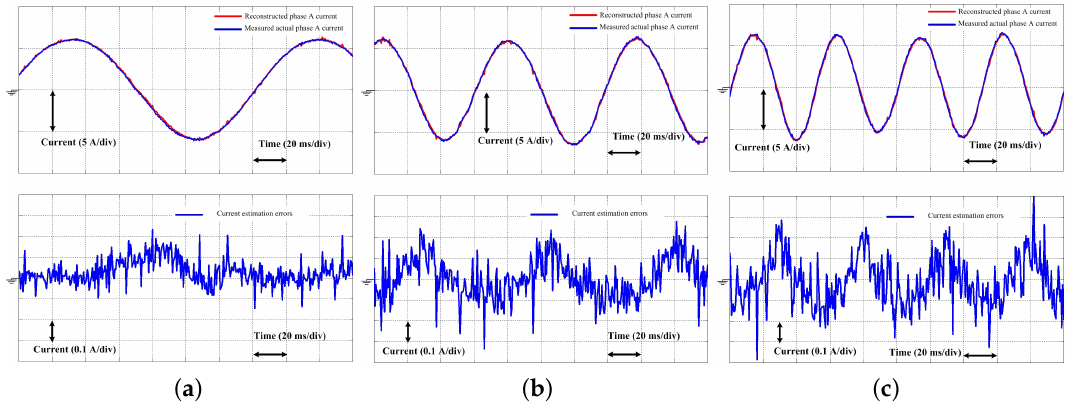
Figure 18. Reconstructed and actual measured phase A currents as well as the current estimation errors of phase A at different motor speeds; time scale: 20 ms/div. ( a ) 100 r/min; ( b ) 200 r/min; and ( c ) 300 r/min.